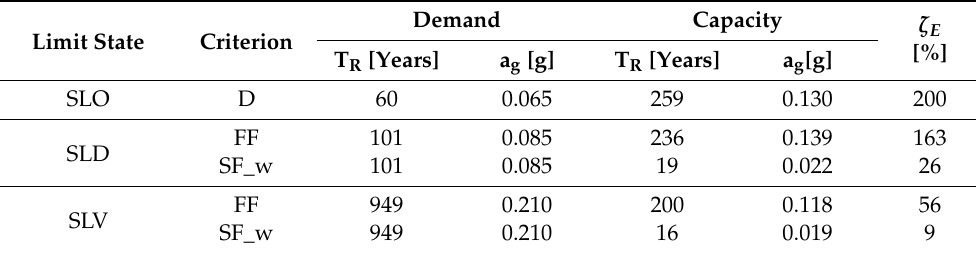
Table 10. Seismic performance